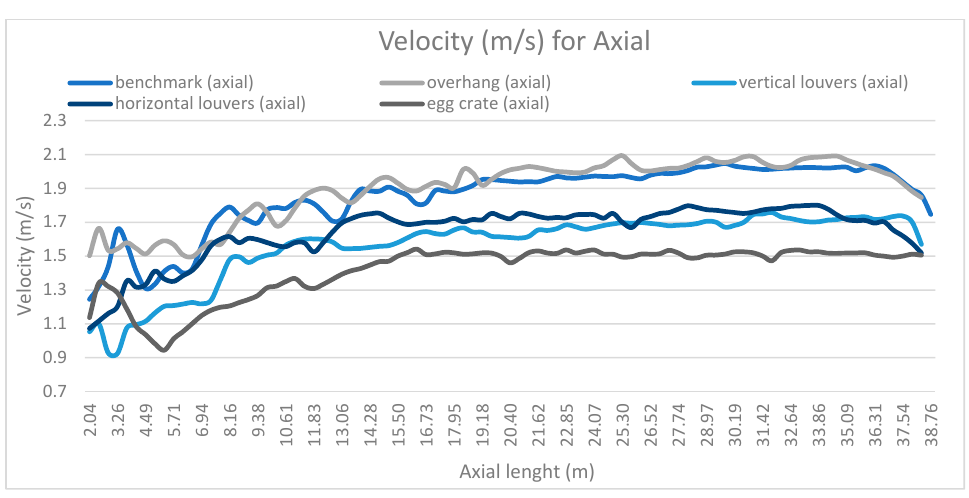
Figure 9. Velocity profile for Axial direction (CFD). Table 14. Results of axial and radial velocity